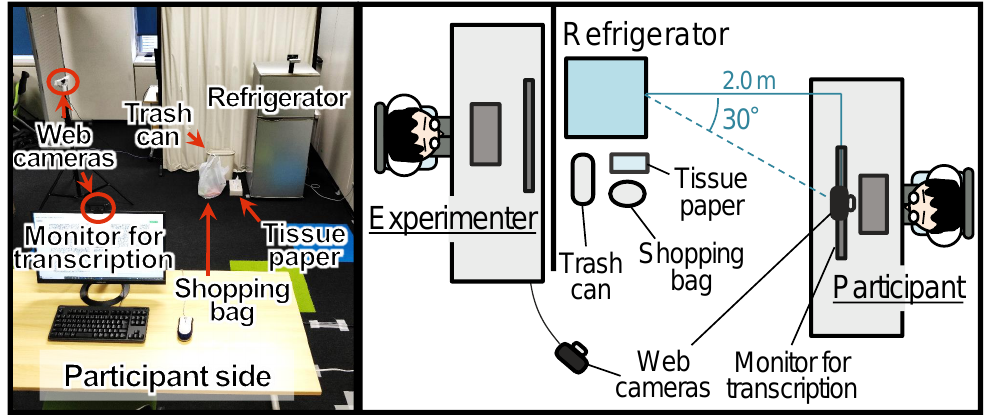
Figure 5. Layout of the